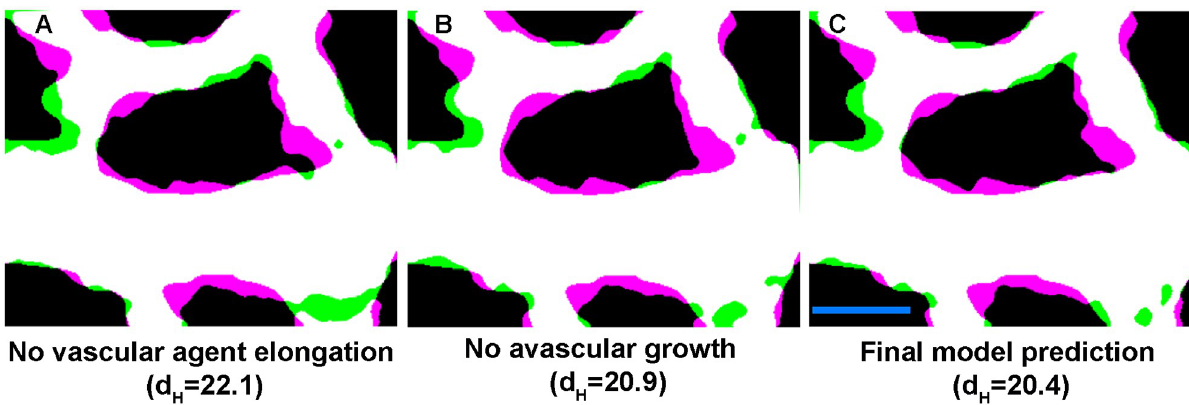
Fig 10. Vascular agent elongation and avascular growth impact the remodelling. A) Error in the final shape with a model without vascular agents’ ellongation. B) Overlay of the final predicted shape without avascular growth. C) Overlay of the final predicted shape with the complete model. Scale bar = 100 μ